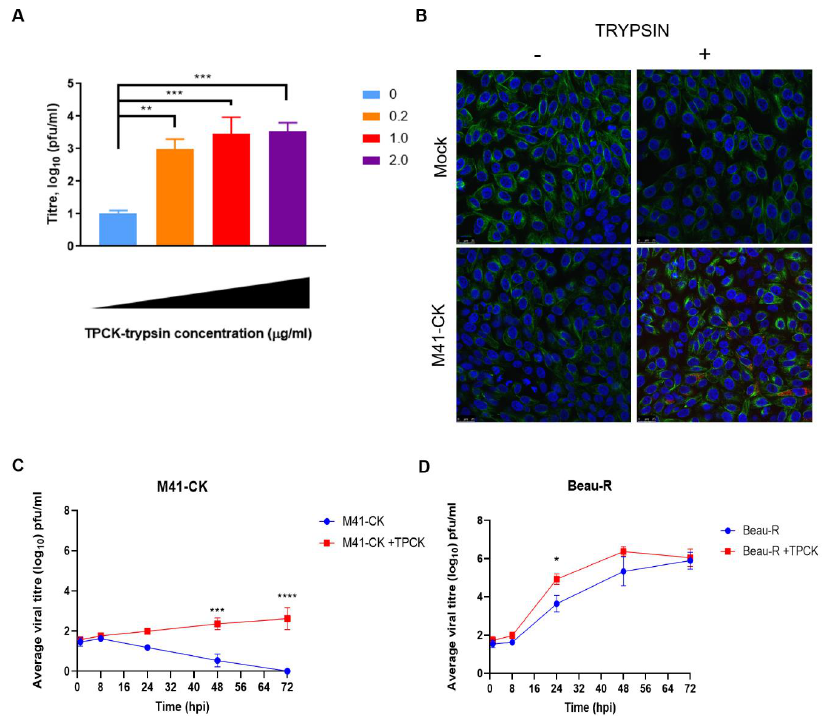
Figure 1. Trypsin enhances infectious bronchitis virus (IBV) replication in Vero cells. ( A ) Vero cells were infected with M41-chicken kidney (CK) (MOI = 1) diluted in 1XBES medium containing increasing concentrations of trypsin treated with L -(tosylamido-2-phenyl) ethyl chloromethyl ketone (TPCK-treated trypsin) from 0–2.0 µg/mL. Supernatant was harvested at 24 hpi and titrated on CK cells in triplicate. Data are representative of three biological replicates. Data were analysed by One- Way ANOVA followed by Tukey’s test for multiple comparisons and statistical differences from the untreated (0 µg/mL TPCK) values are indicated. ** indicates p < 0.01, *** indicates p < 0.001, **** indicates p < 0.0001 . ( B ) Confocal images of Vero cells infected with M41-CK in the presence of trypsin (1.0 µg/mL) compared to mock infected and untreated cells. Cells were stained with monoclonal antibodies against dsRNA (Red) and α-tubulin (Green). Nuclei were stained with DAPI (Blue). White scale bars indicate 25 µ m. Replication kinetics of M41-CK ( C ) and Beau-R ( D ) in the presence of trypsin (1.0 µ g / mL) were assessed in Vero cells. Cells were infected with IBV at MOI of 0.01. Supernatant was harvested at 1, 12, 24, 48 and 72 hpi and titrated on CK cells in triplicate. Average viral titres of at least three biological replicates are displayed with SEM. Statistical di ff erences were calculated by Two-Way ANOVA comparing IBV strains and